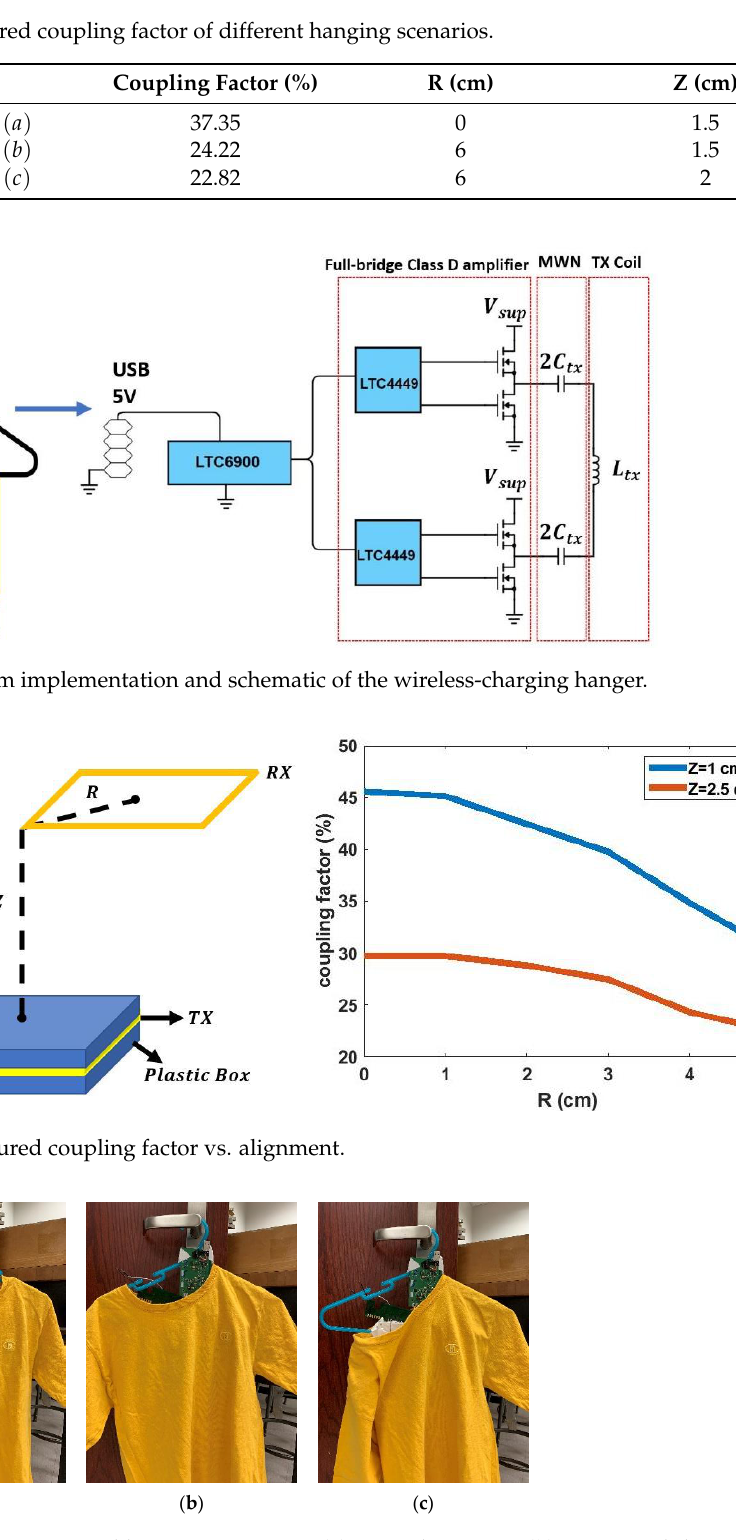
Table 3. Measured coupling factor of different hanging scenarios.